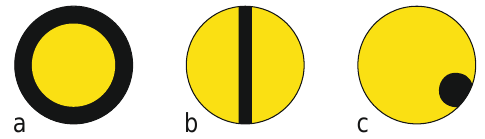
Figure 12. Exemplary cross-sections of antistatic bicomponent fibers: ( a ) concentric core-sheath, ( b ) sandwich side-by-side, ( c ) unequal side-by-side. By way of illustration, the pristine polymer is represented in yellow, and the black parts depict the antistatic component.